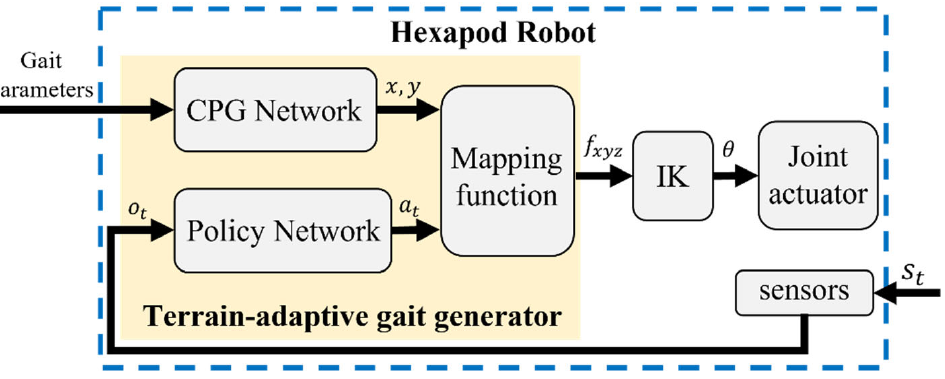
Figure 5. Terrain-adaptive gait generation framework.